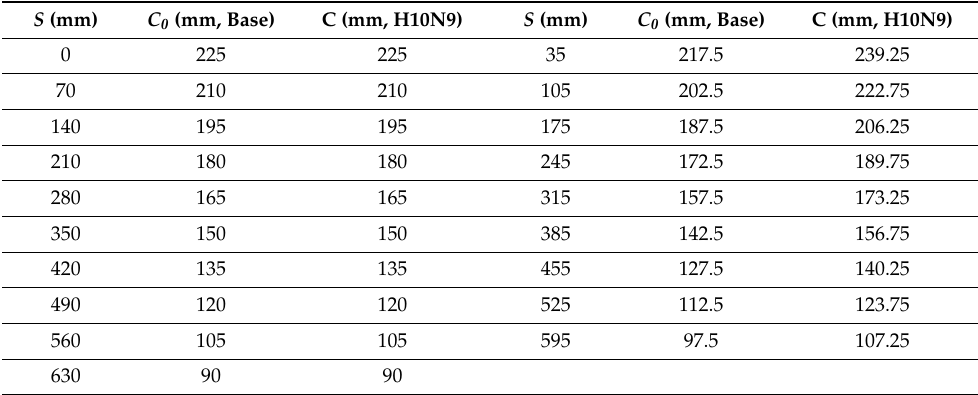
Table 1. Chord distribution of the base blade and bio-inspired blade